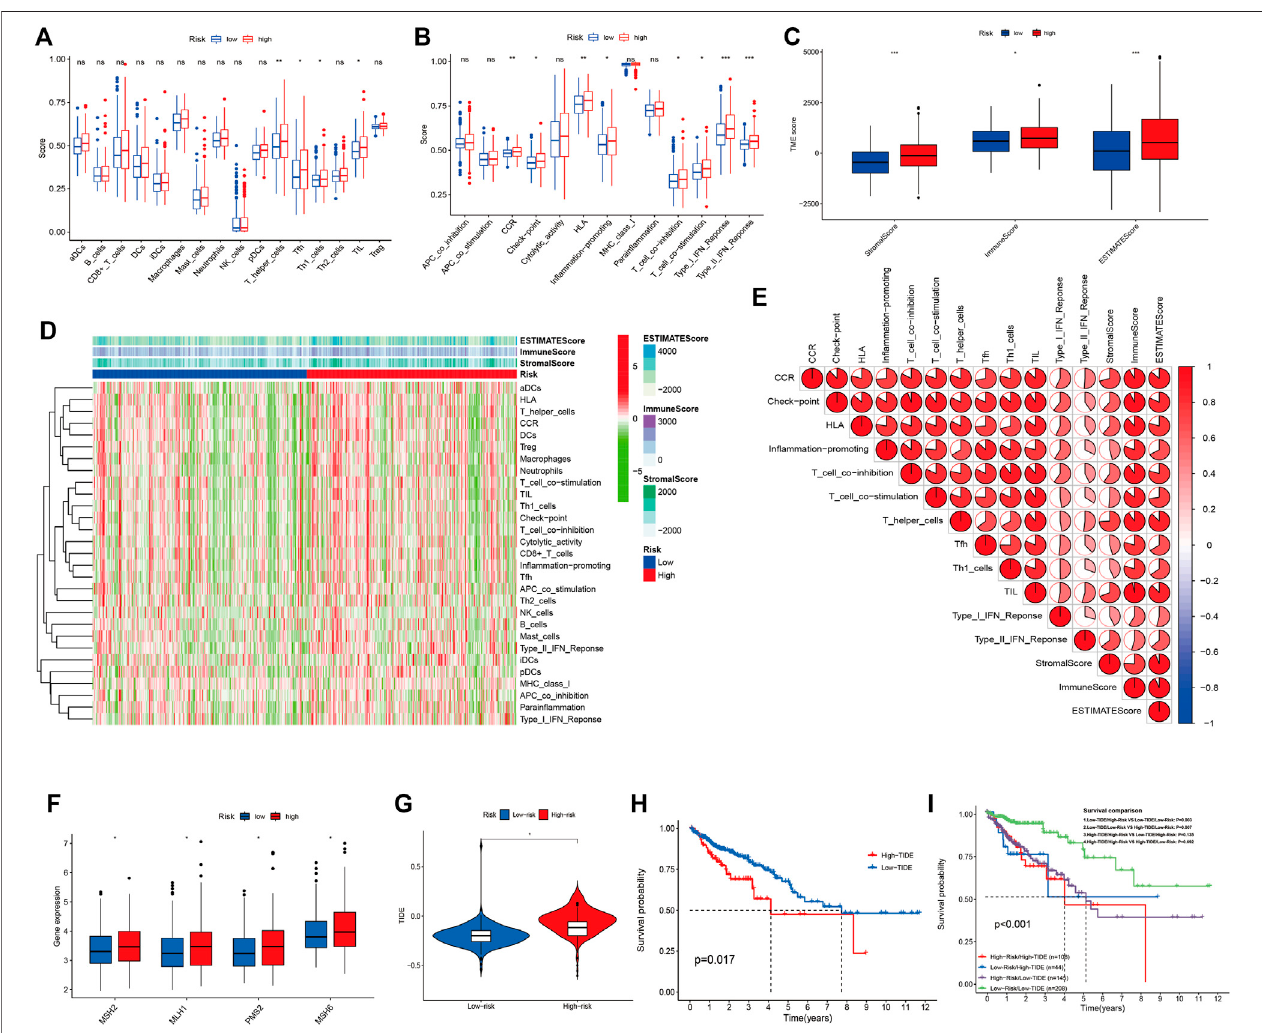
FIGURE 8 | The correlation between the immune in fi ltrations and TME. (A,B) : The differencesof relative abundances of immune components in the high- and low- risk groups. (C) : The differences of Immune score, Stromal score and ESTIMATE score in the high- and low-risk groups. (D) : The distributional correlation between the immune components and TME scores. The red and green strips respectively represent the up-regulated and downregulated immune components. (E) : The co- expression relationship among the differential immune components (T_helper_cells, Tfh, Th1_cells, TIL, CCR, check-point, HLA, in fl ammation-promoting, T_cell_co-inhibition, T_cell_co-stimulation, type_ Ⅰ _IFN_Response, and type_ Ⅱ _IFN_Response) and TME scores. (F) : The expression differences of fi ve immune checkpoints (CTLA4, PDCD1, TIGIT, CD274,and HAVCR2) in thehigh- and low-risk groups. (G) : Thedifference ofTIDEscore inthehigh- and low-riskgroups. (H) : The K-M survival curves indicating the overall survival difference between the TCGA CRC patients with high-TIDE score and low-TIDE score. (I) : The K-M survival curves strati fi ed by the fi ve-GMRHG prognostic signature and TIDE score. The overall survival of TCGA CRC patients with Low-TIDE/High-Risk was lower than that with Low- TIDE/Low-Risk with statistical differences( p (cid:1) 0.003). The overall survival of TCGA CRC patients with Low-TIDE/Low-Risk was lower than thatwith High-TIDE/Low-risk with statistical differences ( p (cid:1) 0.007). Moreover, there were no statistical differences of the overall survival between TCGA CRC patients with High-TIDE/High-Risk VS TCGA CRC patients with Low-TIDE/High-Risk ( p (cid:1) 0.135) and TCGA CRC patients with High-TIDE/High-Risk VS TCGA CRC patients with High-TIDE/Low-Risk ( p (cid:1) 0.692).